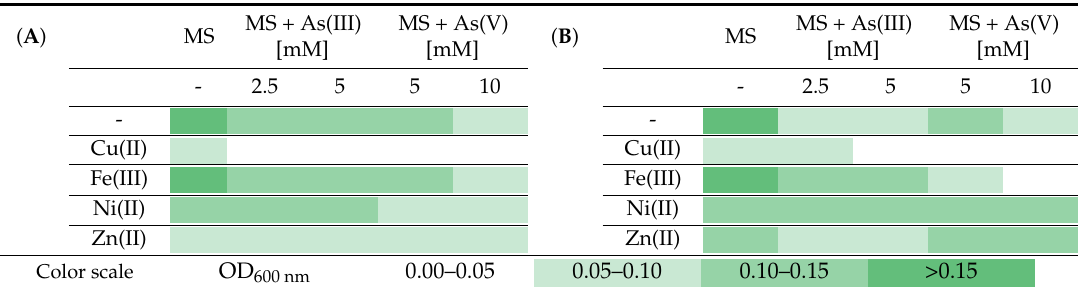
Table 4. Growth of Shewanella sp. O23S for 96 h at room temperature in MS medium (pH 7.5) without ( A ) or with ( B ) the addition of 10 mM Tris-HCl buffer. The media in respective variants were supplemented with As(III) (2.5 or 5 mM) or As(V) (2.5 or 5 mM) and 1 mM of Cu(II), Fe(III), Ni(II) or Zn(II). Media without arsenic were used as the